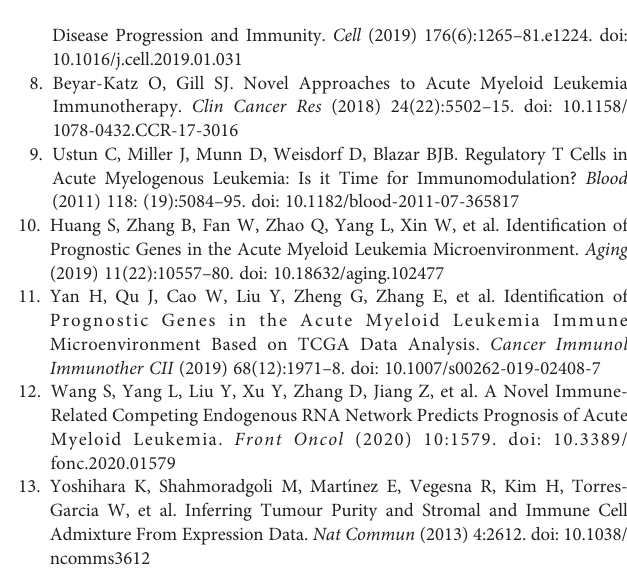
Supplementary Figure 1 | Enrichment analysis of differentially expressed genes (DEGs) derived from AML patients and healthy individuals. (A) The top 10 Gene Ontology (GO) terms of biological process. (B) The top 5 Kyoto Encyclopedia of Genes and Genomes (KEGG) terms. Supplementary Figure 2 | Strati fi cation analysis. Kaplan-Meier analysis of AML patients from TCGA-LAML cohort strati fi ed by age (A) and ELN risk strati fi cation system (B) . Supplementary Table 1 | 2516 DEGs between AML patients and healthy individuals. Supplementary Table 2 | 199 differentially expressed IRGs between AML patients and healthy individuals. Supplementary Table 3 | Univariate Cox analysis of 199 differentially expressed